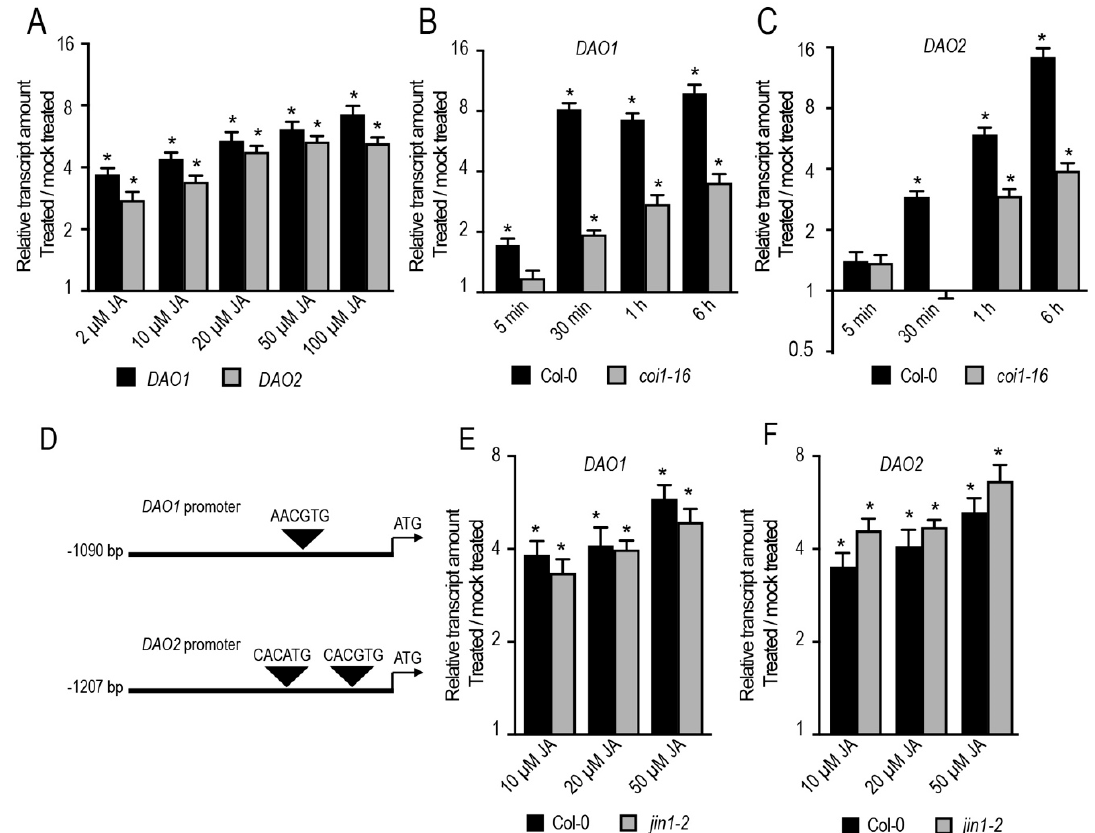
Figure 1. Jasmonate (JA) controls the expression of DAO1 and DAO2. ( A ) Relative transcript amount of DAO1 and DAO2 quantified by qRT-PCR. mRNAs were extracted from six-day-old wild-type seedlings treated for 1 h either with different doses of JA or mock solution. The gene expression values are relative to the mock-treated control, for which the value was arbitrarily set to 1. The scale in the Y axis is indicated as a log2 unit. Error bars indicate ± SD obtained from three technical replicates. ( B , C ) Relative transcript amount of DAO1 and DAO2 quantified by qRT-PCR. mRNAs were extracted from six-day-old wild-type or coi1-16 mutant seedlings treated with 50 μ M JA or mock solution at different time points. The gene expression values are relative to the mock-treated control, for which the value was arbitrarily set to 1. Error bars indicate ± SD obtained from three technical replicates. ( D ) Representative scheme of the location of G-box or G-box-like cis regulatory elements on the DAO1 and DAO2 promoters. ( E , F ) Relative transcript amount of DAO1 and DAO2 quantified by qRT-PCR. mRNAs were extracted from six-day-old wild-type or jin1-2 mutant seedlings treated for 1 h with different JA doses or mock solutions. The gene expression values are relative to the mock-treated control, for which the value was set to 1. Error bars indicate ± SD obtained from three technical replicates. A t -test indicates that the values indicated by an asterisk are significantly different from their mock counterpart ( p < 0.01; n = 3). All wild-type and mutant seedlings were grown for five days under long-day conditions (16 h light/8 h dark), then they were acclimated overnight in liquid media before any treatment. All the experiments were repeated with another independent biological replicate and gave similar results.